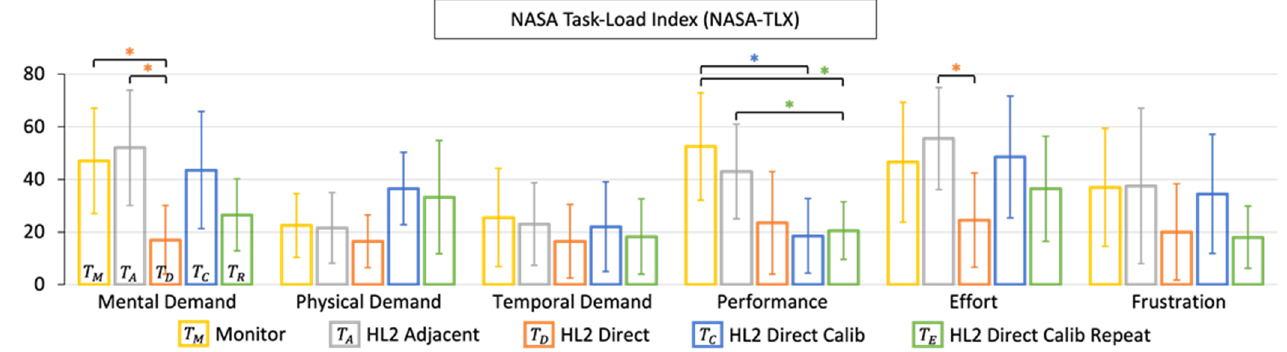
Figure 6. Qualitative results of the user-study. We report the results of the self-reported NASA task load index (NASA-TLX) scoring, which was performed after each paradigm of the point-and-trace user-study. HoloLens 2 (HL2) tasks are labelled. Significant results ( 𝑝 < 0.05 ) are indicated by an Asterix